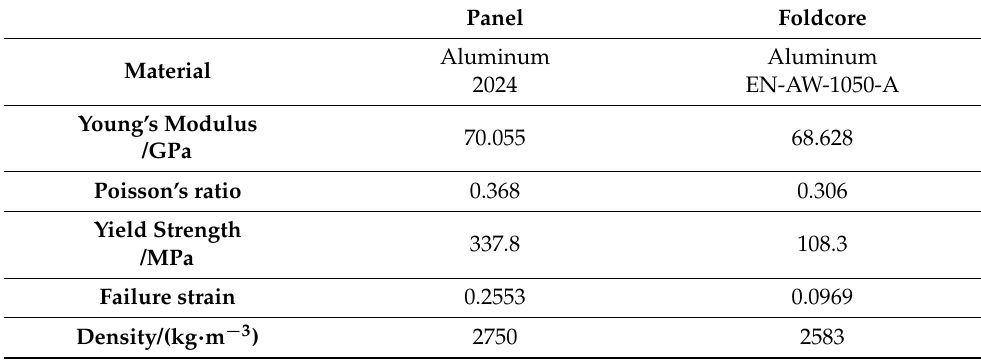
Table 2. Material properties of panels and foldcore.